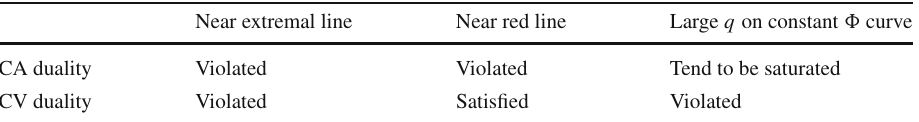
Table 1 Check of whether the Near extremal line Near red line Large q on constant (cid:3) curve generalized Lloyd bound is violated or satisfied CA duality Violated Violated Tend to be saturated CV duality Violated Satisfied